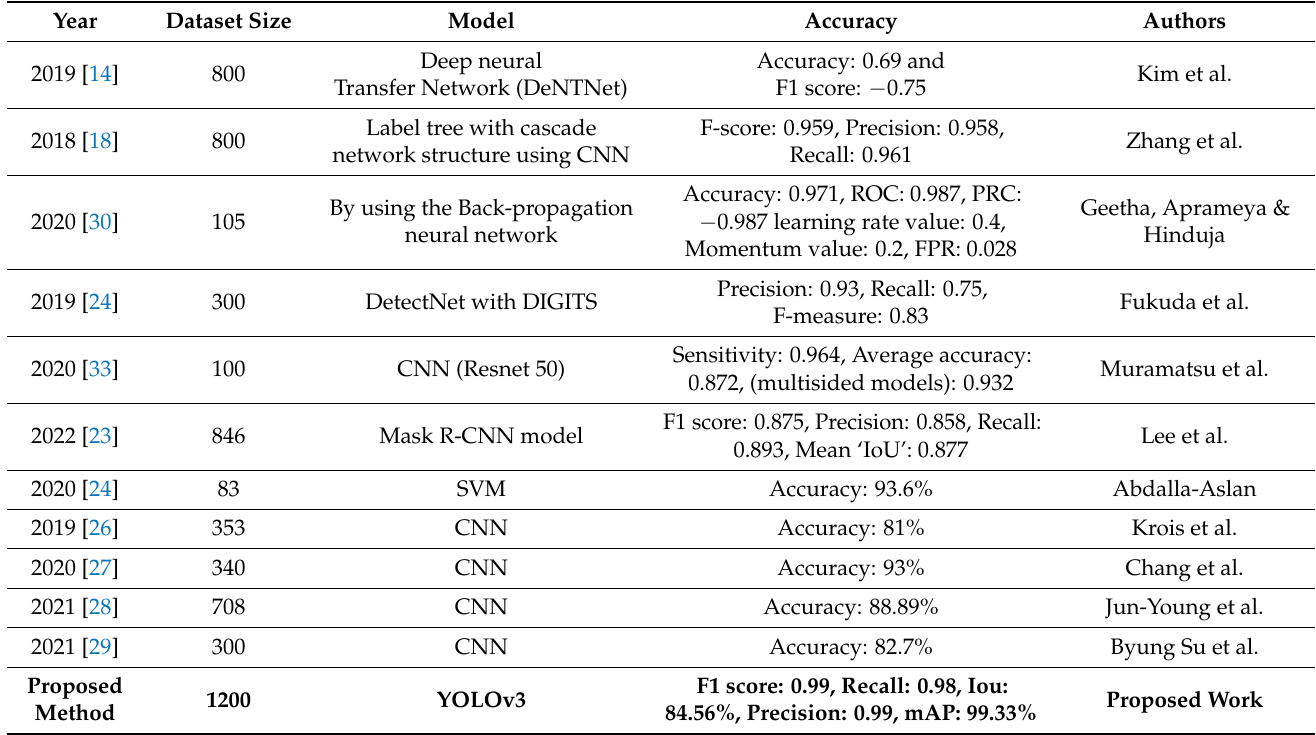
Table 7. Comparative study of the proposed model with recent DL